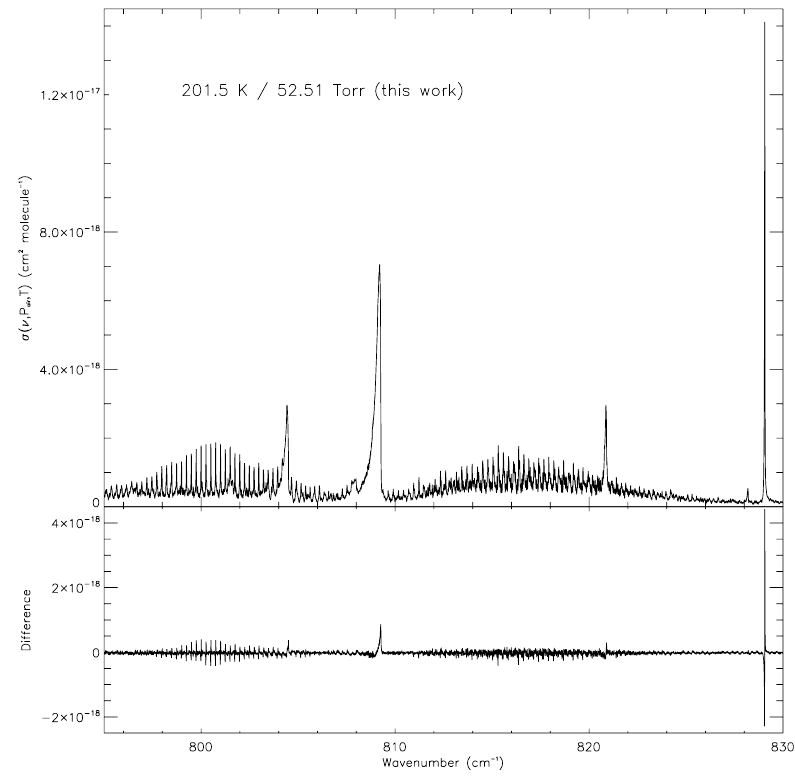
Figure 3. Top: the new IR absorption cross section of chlorodifluoromethane/dry synthetic air at 201.5K and 52.51Torr, covering part of the ν 4 and 2 ν 6 bands. Bottom: the difference between the new cross section and the re-baselined and re-normalised Varanasi cross section at 201.0K and 50.4Torr (new – old). The observed features in the difference plot are indicative of poor wavenumber calibration in the Varanasi cross section.